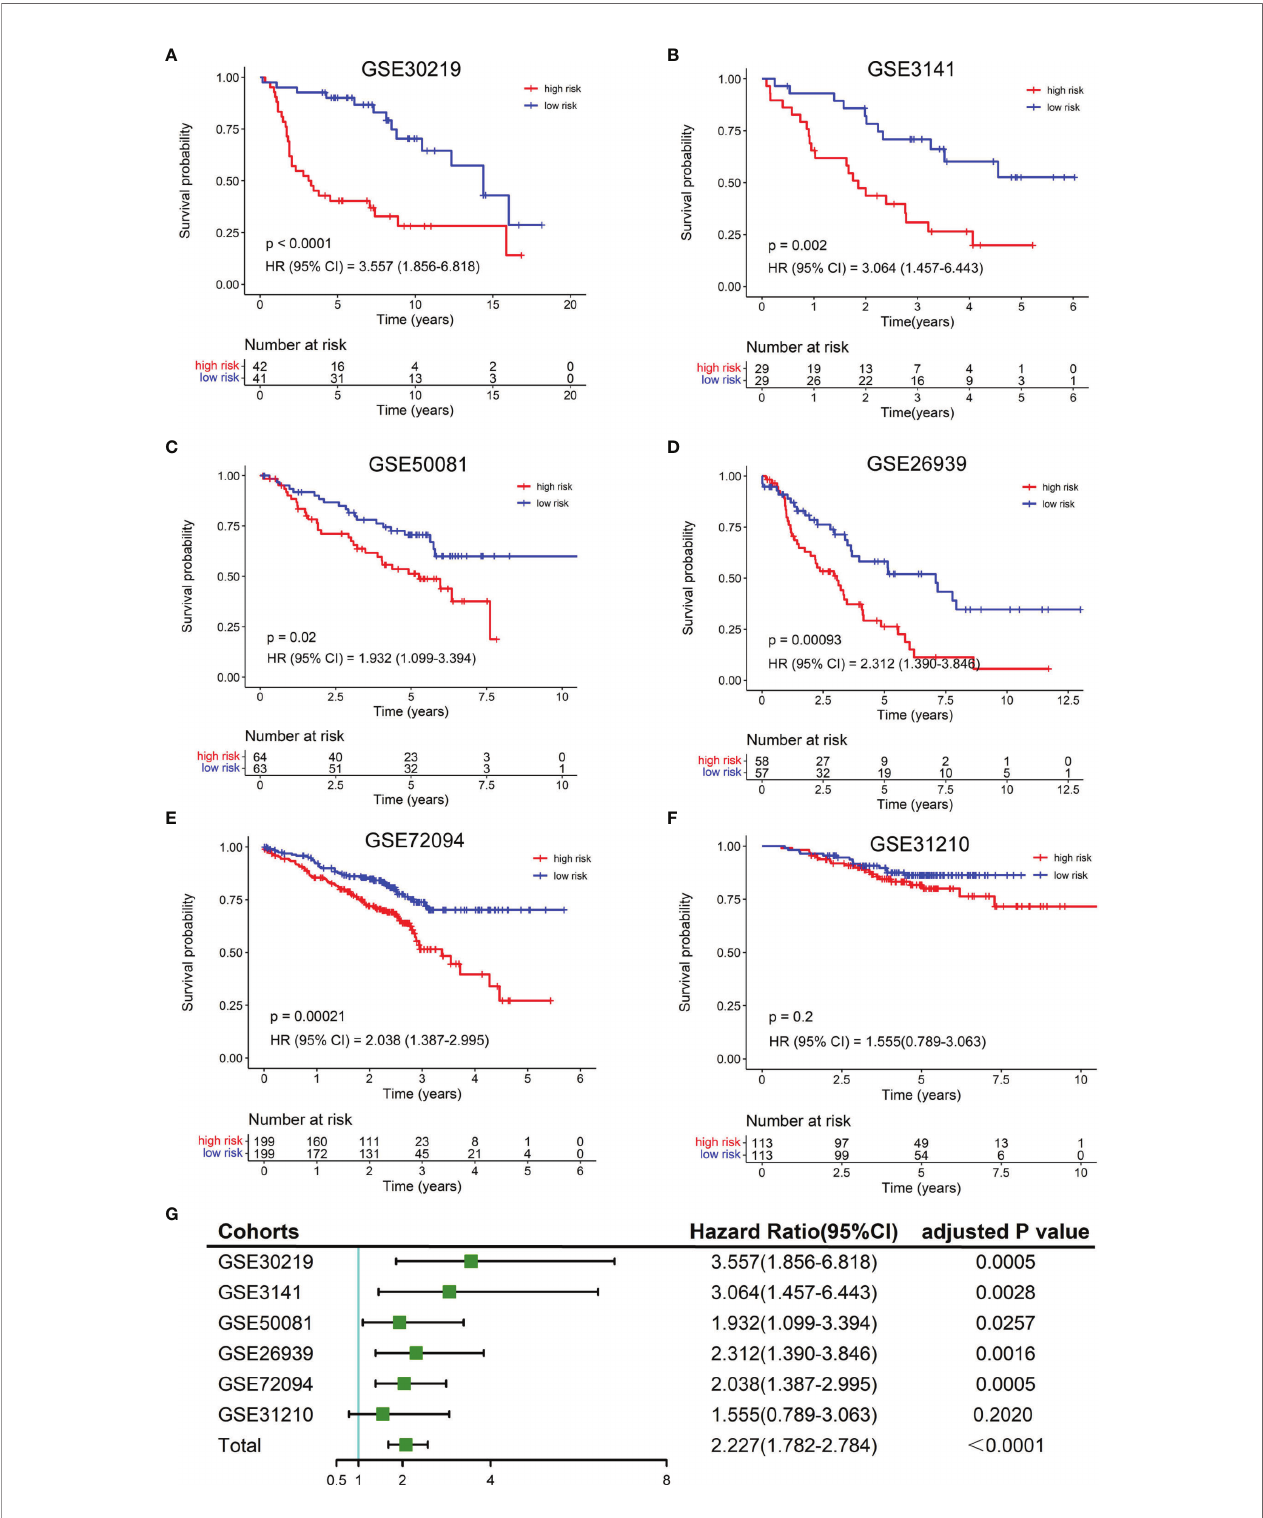
FIGURE 3 | Validation of the NKCMGS in six independent GEO cohorts. (A) GSE31210 (n = 226). (B) GSE30219 (n = 83). (C) GSE37745 (n = 106). (D) GSE50081 (n = 127). (E) GSE26939 (n = 115). (F) GSE42127 (n = 133). (G) A meta-analysis of six GEO cohorts and the P-value was adjusted for 7 hypothesis